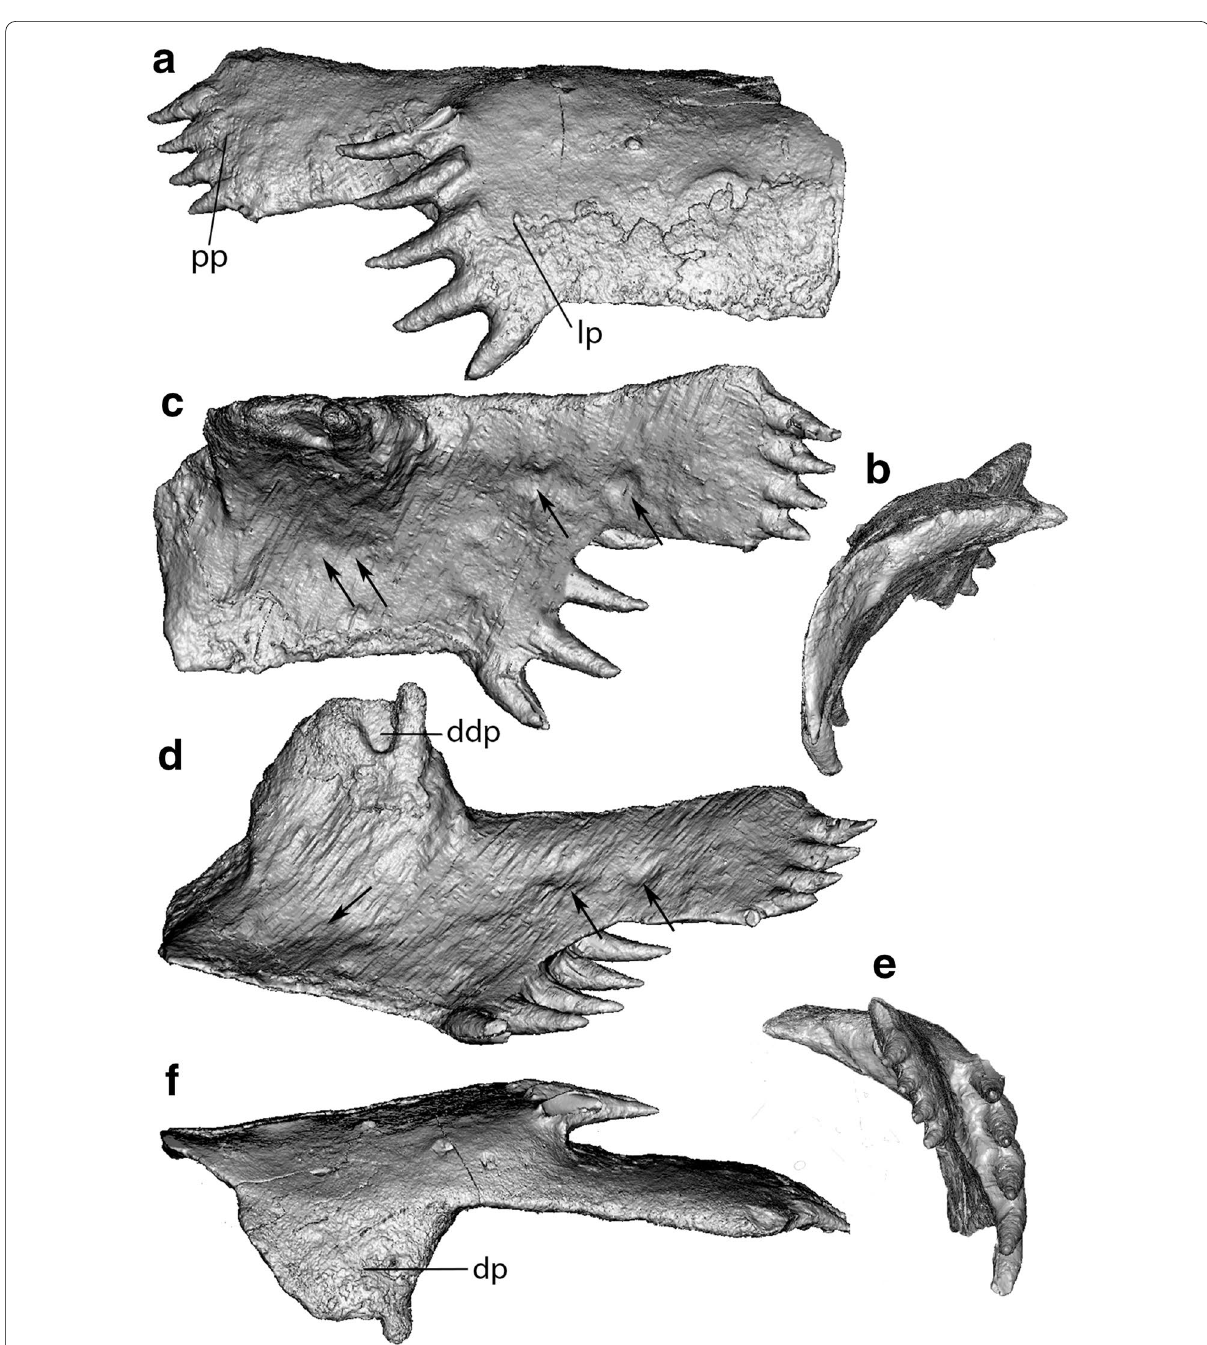
Fig. 3 CT reconstruction of the posterior superognathal of Leptodontichthys ziregensis gen. et sp. nov. (PIMUZ A/I 5022) in labial ( a ), anterior ( b ), lingual ( c ), ventro-lingual ( d ), posterior ( e ) and dorsal ( f ) view. Putative occlusal marks of the inferognathal are indicated by arrows in c and d . Scale is 100 mm. dp, dorsal process; ddp, depression of the dorsal process; lp, lateral process; pp, posterior